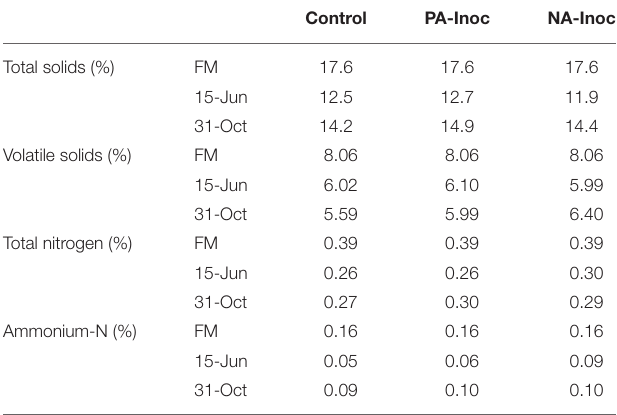
TABLE 2 | Manure total solids (%), volatile solids (%), total nitrogen (%), and ammonium-nitrogen (%) sampled from fresh manure (FM) during tank filling (May 29, 2018), and stored manure on 7 days (Jun 15, 2018), and 155 days (Nov 11, 2018).